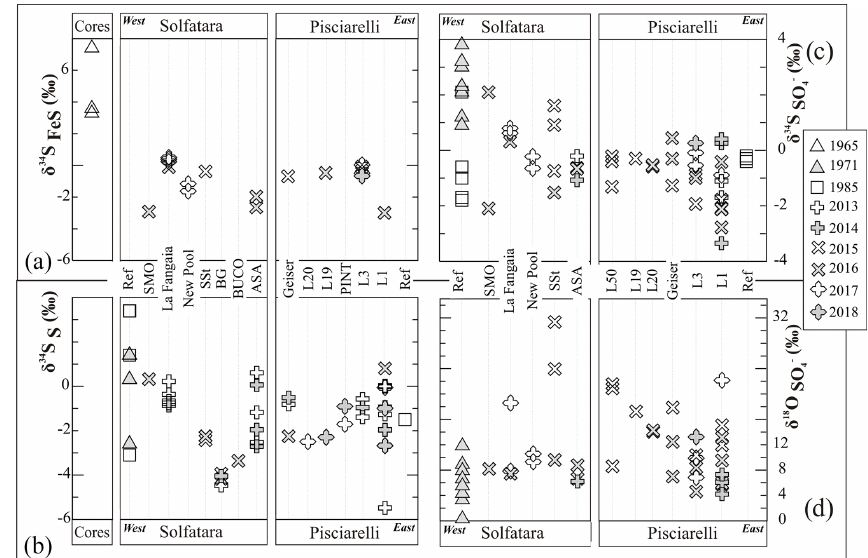
Figure 5. Distribution of δ 34 S values for sulfides (a) , native sulfur (b) and sulfates (c) and of δ 18 O values for sulfates at the different sampling sites arranged by sampling date. Results from cores collected in 1965 and 1971, 1984, 2013 and 2014 are compiled from the literature (i.e., Cortecci et al., 1978; Valentino et al., 1999; Valentino and Stanzione, 2003, 2004; Piochi et al., 2015). Sampling sites are shown in Fig. 1a, d, e; “Ref” indicates literature data. Note the values are plotted based on sample sites, from west to east.